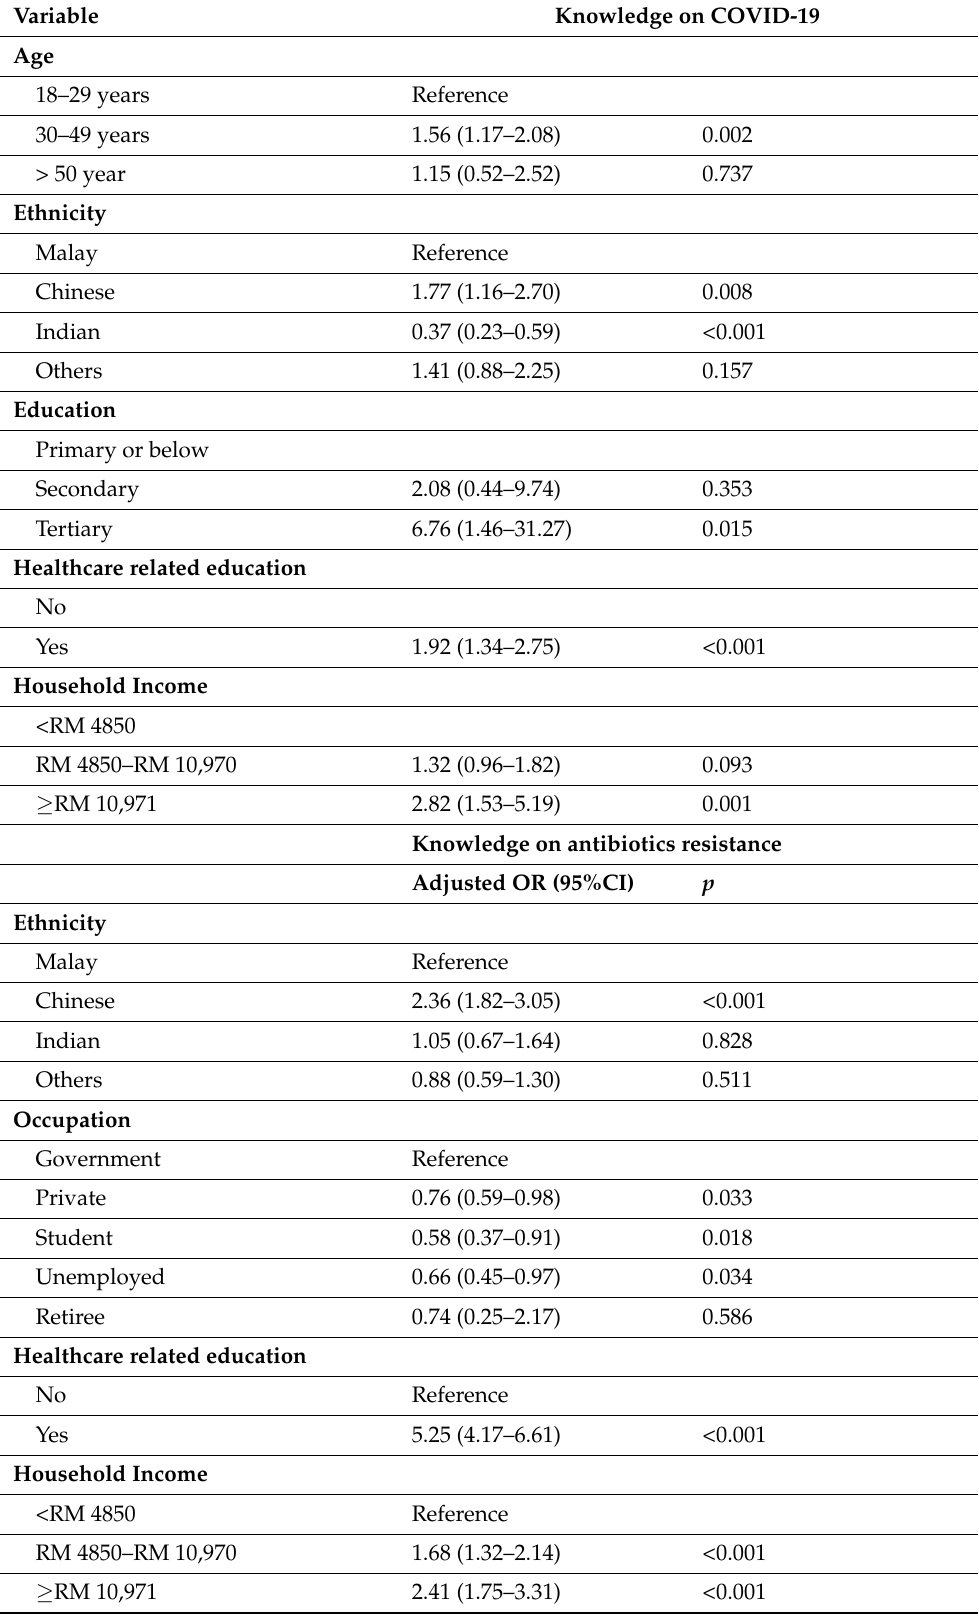
Table 4. Multiple logistic regression for significant factors associated with knowledge on COVID-19, knowledge on antibiotics resistance, practice and attitudes score ( n =